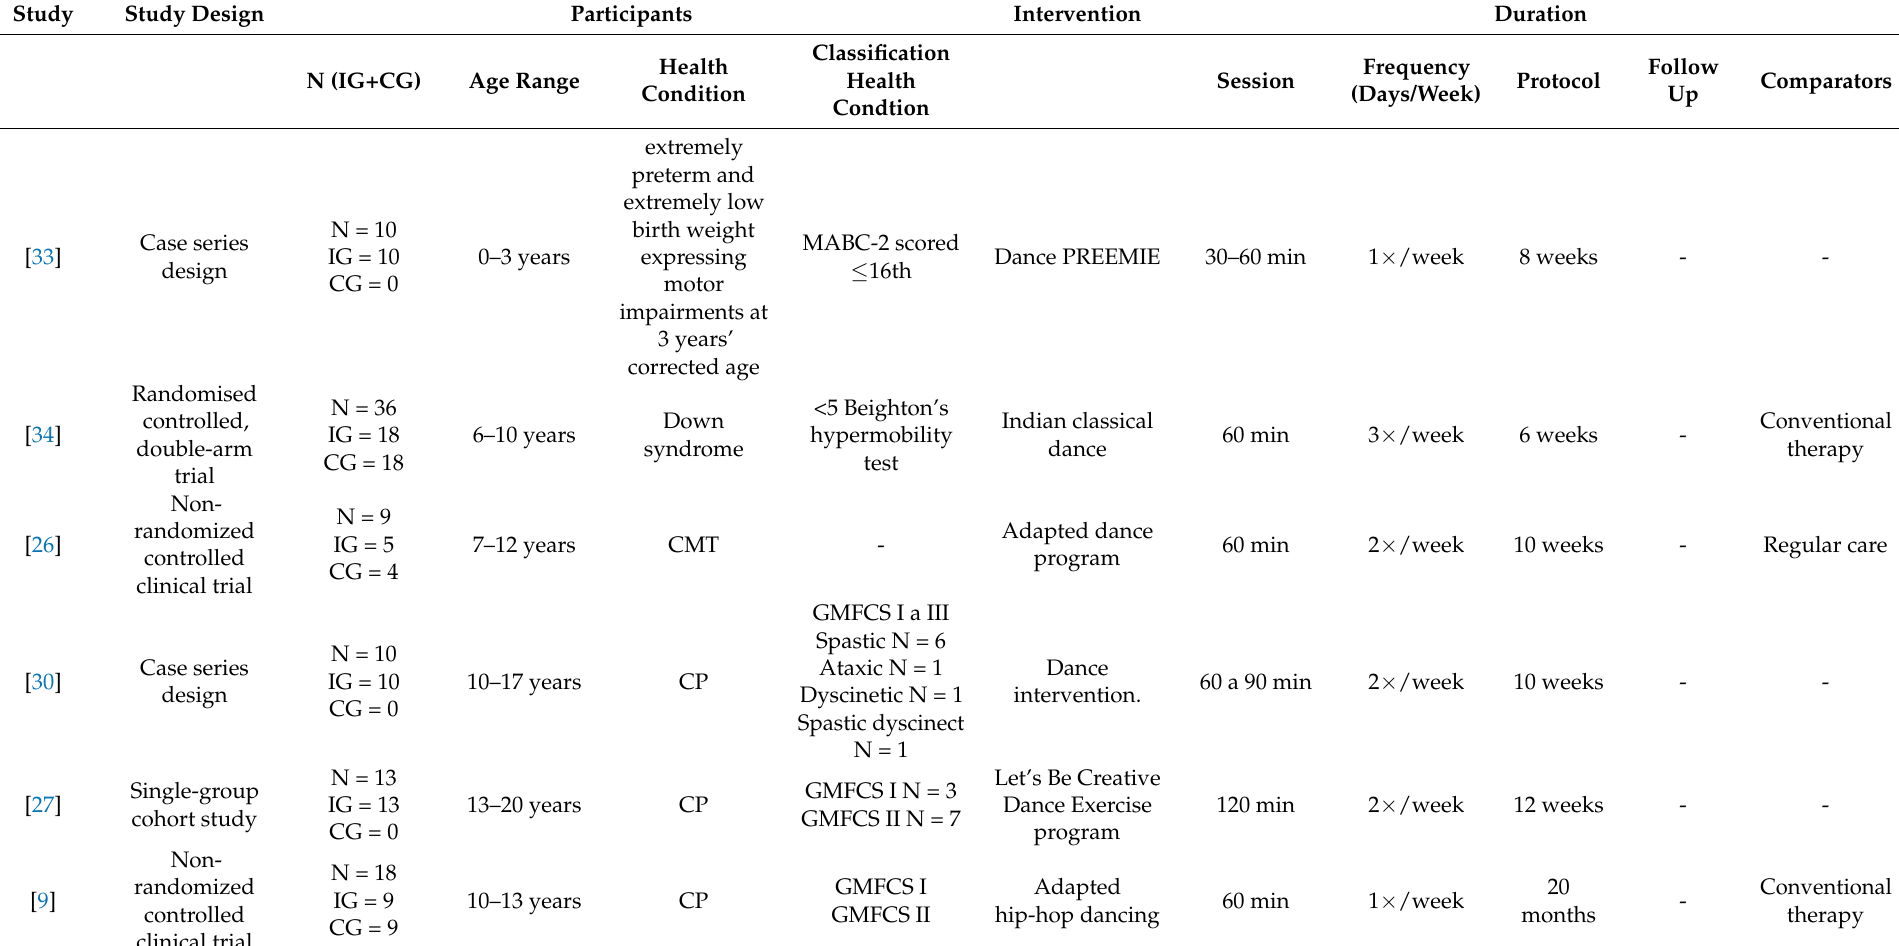
Table 1. Participants and intervention